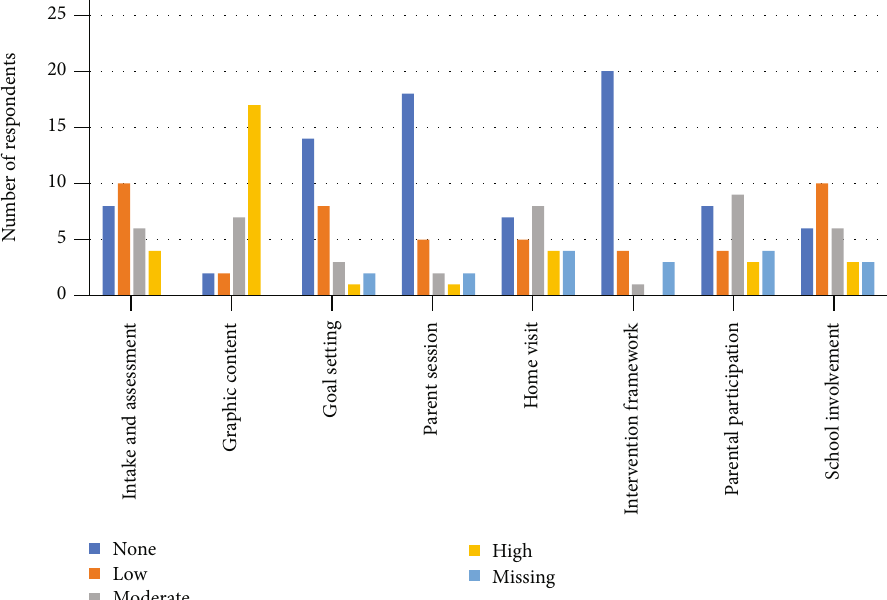
Figure 2: Adaptations necessary to the intervention protocol ( N = 28